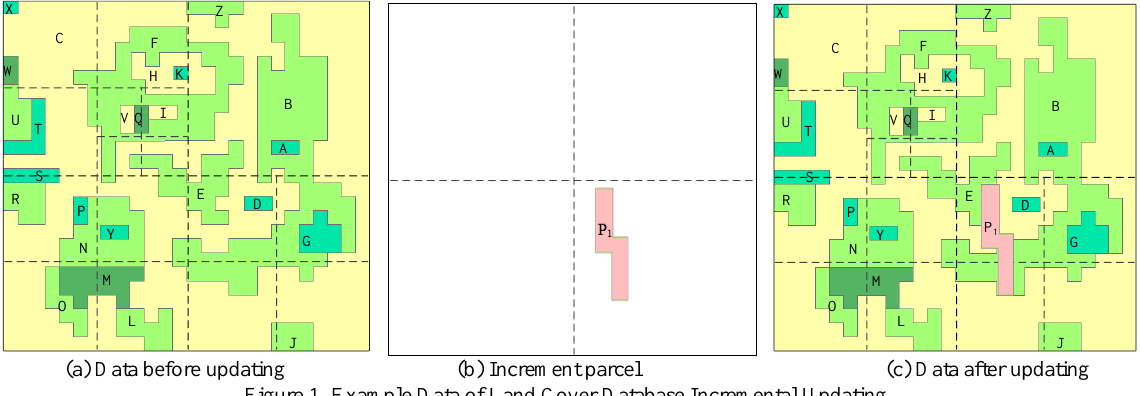
Figure 1. Example Data of Land Cover Database Incremental